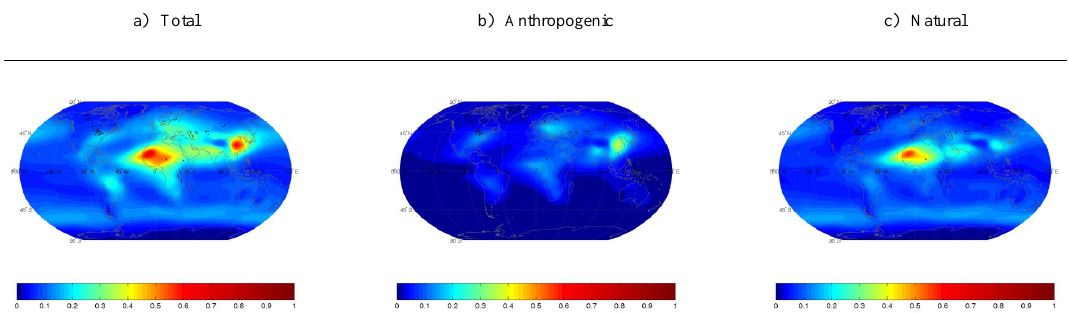
Figure 1. Hamburg Aerosol Climatology (HAC) global annual distribution of aerosol optical depth at 550nm. Results are given for (a) total, (b) anthropogenic (consisting of fine mode only), and (c) natural (pre-industrial fine mode + coarse) aerosol.